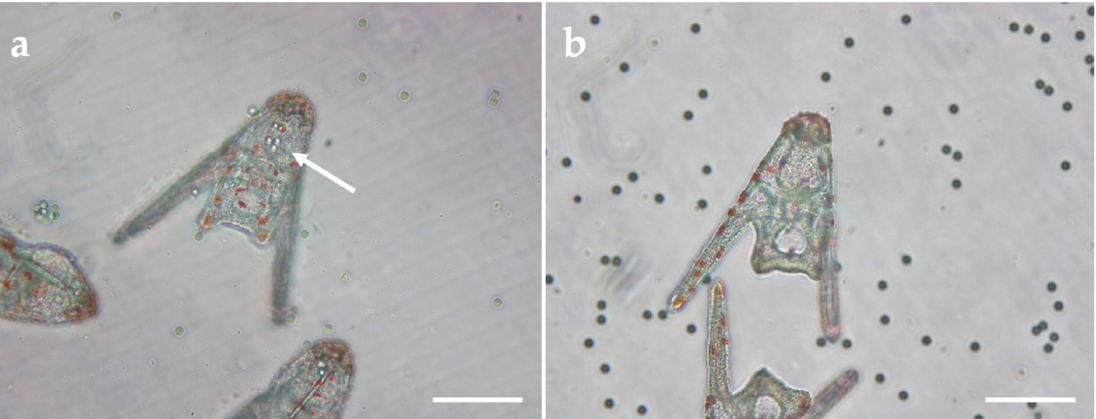
Figure 6. Representative images of A. lixula embryos with ( a ) ingested 10 μ m PMMA microparticles (indicated by arrow) and ( b ) lack of ingestion after co-exposure to microparticles and cypermethrin (scale bar 100 μ m).